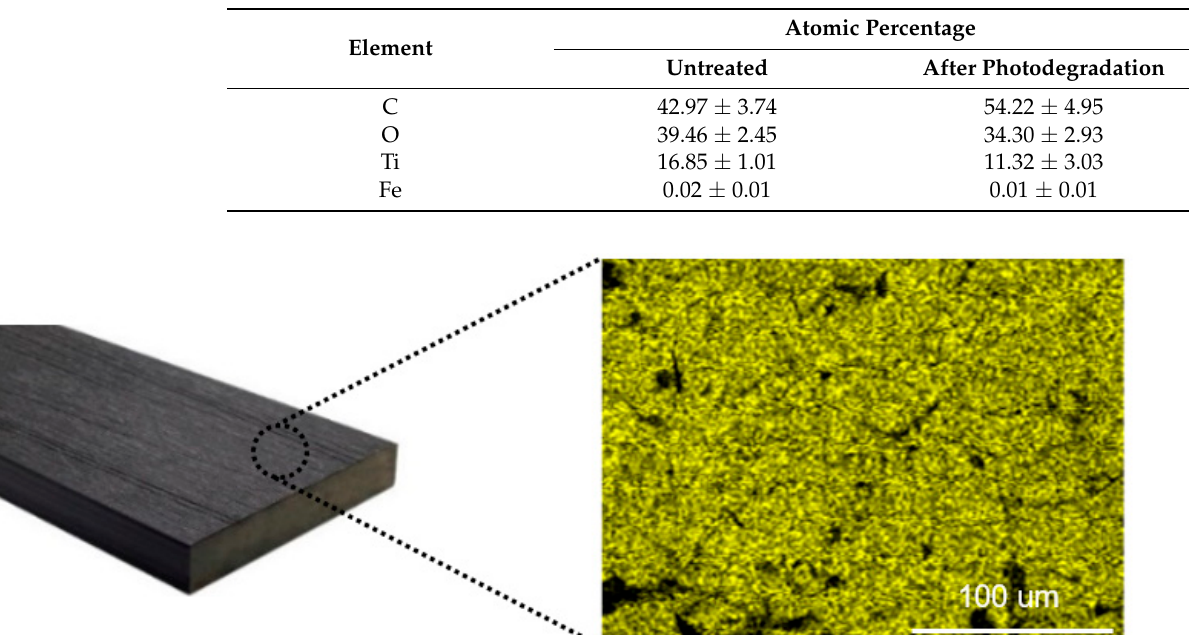
Figure 10. EDS spectra on the surface of Fe/TiO 2 –cMDF (Blue LED). Table 3. Elemental analysis on the surface of Fe/TiO 2 –cMDF (Blue LED).